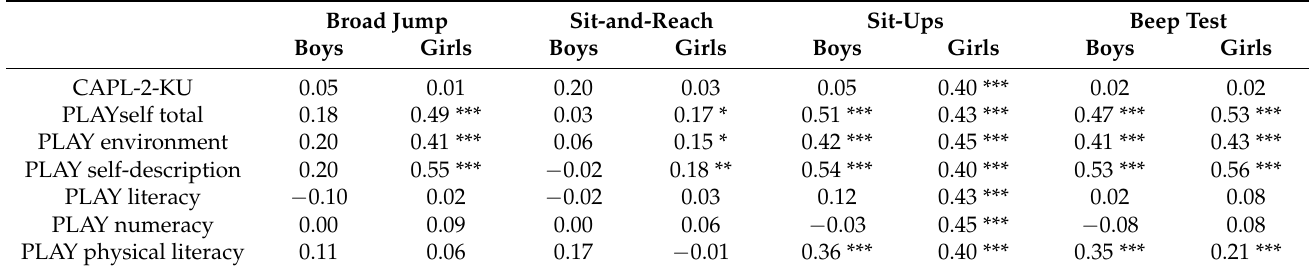
Table 4. Correlations between physical fitness tests and variables of physical literacy. Broad Jump Sit-and-Reach